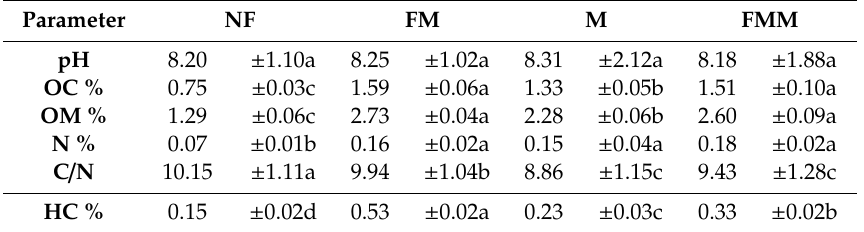
Table 1. Values of pH, organic carbon (OC), organic matter (OM), nitrogen (N) and C / N of earthworm coprolites, and humic carbon (HC) of humic substances extracted from earthworm coprolites collected in soil plots fertilized with no inputs (NF), manure (FM), mineral fertilizers (M) and with manure plus mineral fertilizers (FMM). Data represent the means of three measurements. Values in the same row following the same letter are not statistically di ff erent at p < 0.05 according to Student-Newman-Keuls